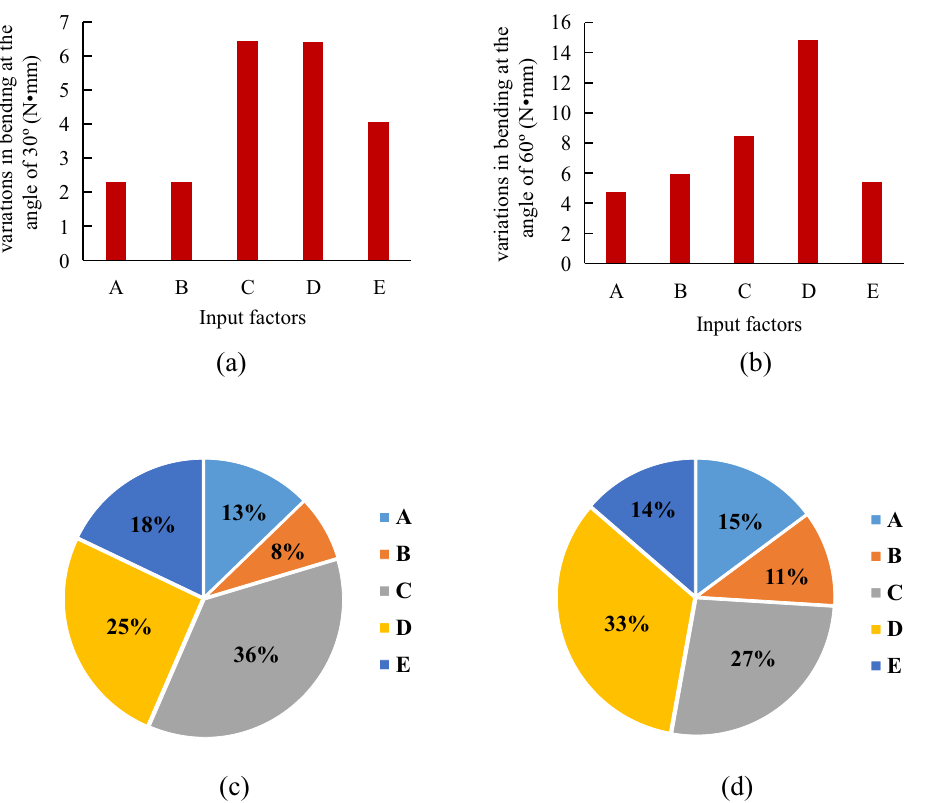
Figure 4: Diagram of the range value on the bending moment at the bending angle of 30° and 60° and normalized at 30° ( c ) and 60° ( d ) to various input factors. A – PET strip modulus ( GPa ) , B – number of nitinol wire, C – initial braiding angle ( ° ) , D – nitinol wire diameter ( mm ) , and E – PET strip thickness ( mm )